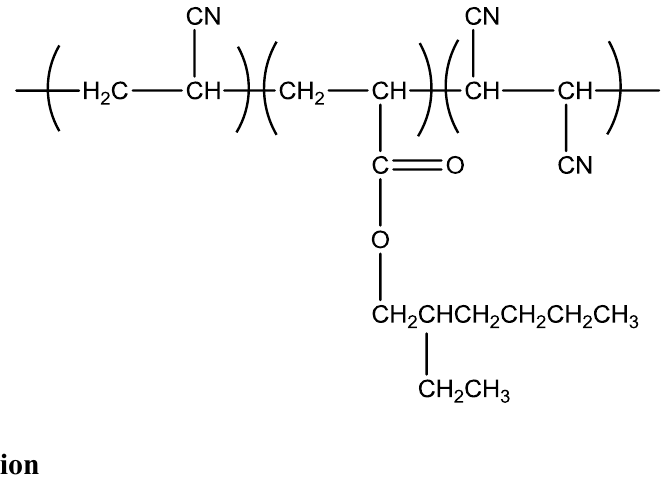
Figure 2. Poly(acrylonitrile/ethyl hexyl acrylate/fumaronitrile).